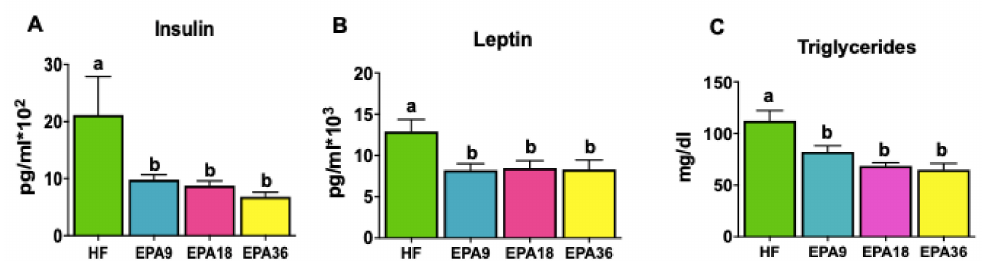
Figure 4. Dose-dependent e ff ects of EPA on serum insulin, leptin, and triglycerides levels in mice . ( A ) EPA9, 18, and 36 significantly decreased the insulin level compared to HF, ( B ) EPA9, 18, and 36 significantly decreased the leptin levels compared to HF. ( C ) EPA9, 18, and 36 significantly reduced triglycerides levels in serum compared to HF. Data are expressed as mean ± SEM. Groups represented with same letter indicate no di ff erence. p < 0.05; n = 8–15 mice per group. EPA, eicosapentaenoic acid; HF, high fat.